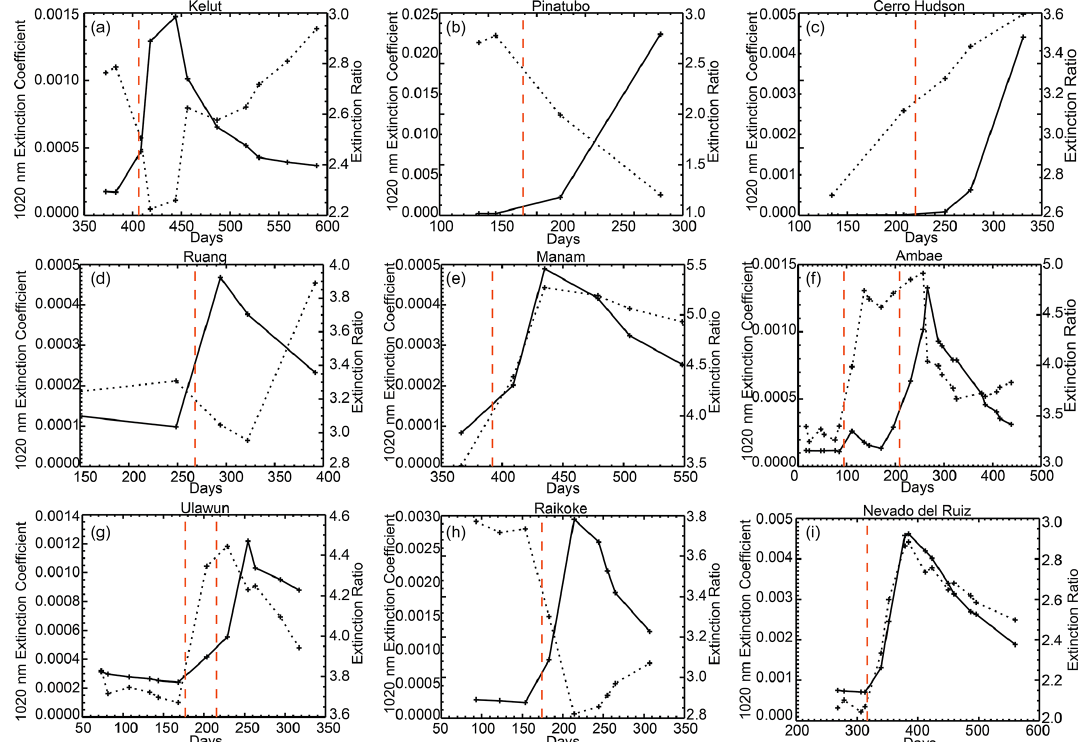
Figure 7. Similar analysis as that shown in Fig. 6 except for Kelut in 1990 (a) ; Mt. Pinatubo (b) and Cerro Hudson (c) in 1991; Ruang in 2002 (d) ; Manam in 2005 (e) ; Ambae in 2018 (f) ; and Ulawun (g) and Raikoke (h) in 2019. In each frame, extinction coefficient is the solid line and the extinction coefficient ratio is the dotted line. The dates of the eruptions are denoted by the vertical red dashed lines. The plot for the Nevado del Ruiz eruption shown in Fig. 6 is repeated here in panel (i) for comparison. Days refer to the number of days since the start of year in which the analysis begins for an individual eruption. For panels (a) to (i) these years are 1989, 1991, 1991, 2002, 2004, 2018, 2019, and 2019,